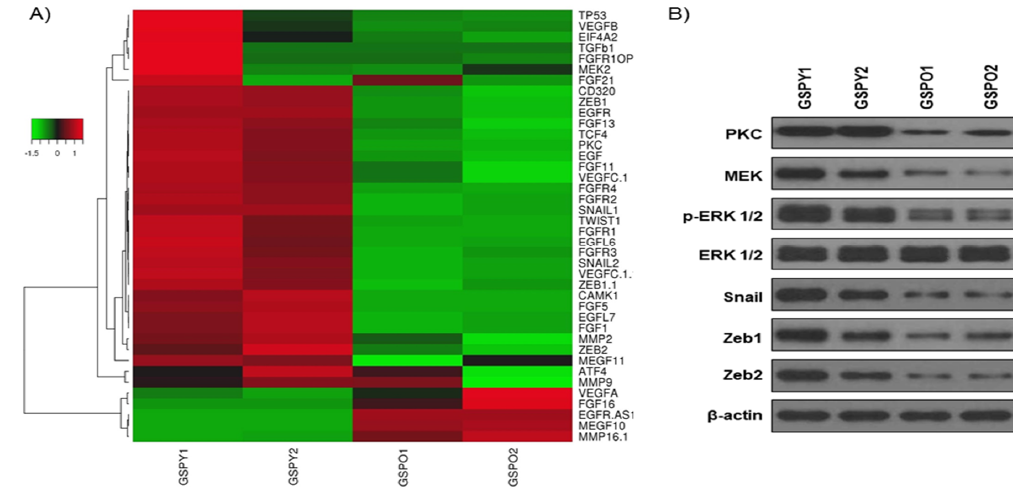
Figure 1. Gene expression profiles of patient-derived papillary thyroid cancer (PTC) cells. Gene expression analysis using a microarray approach between PTC of young (GSPY) and old (GSPO) individuals. ( A ) Gene expression profiles based on microarray. Hierarchical clustering analysis for comparison of GSPY and GSPO samples. ( B ) Immunoblot analysis for markers of FGFR signaling pathway and EMT in GSPY and GSPO samples.